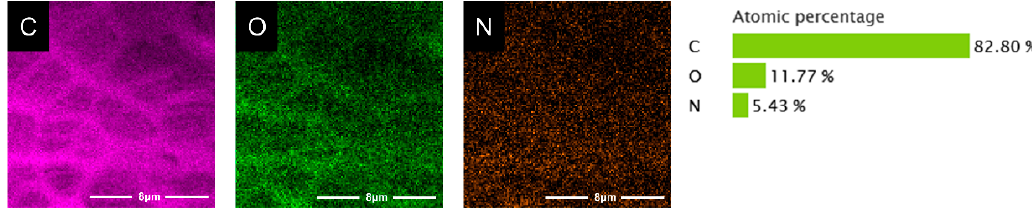
Figure 7. EDS map of C (purple), O (green), and N (orange) atoms on PDA/PLA scaffolds.